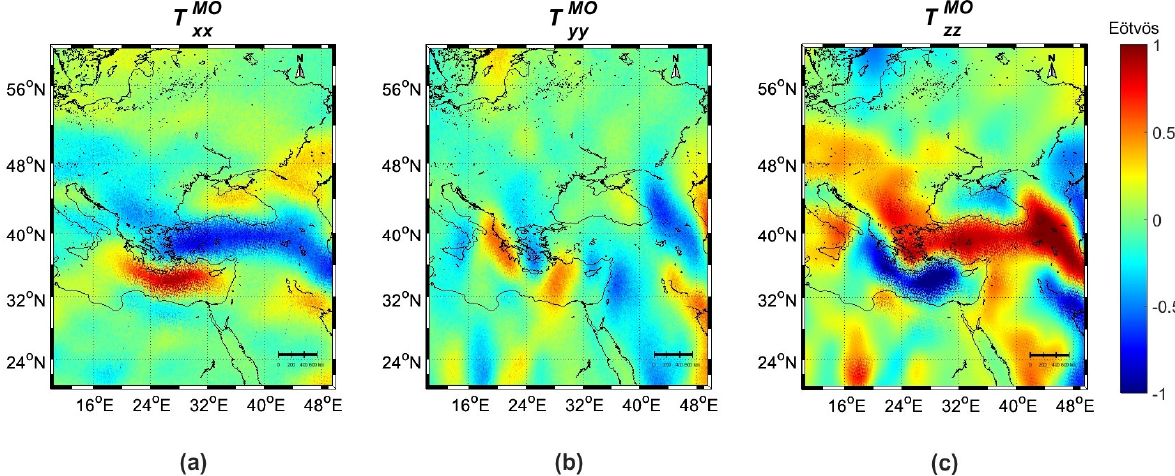
Figure 2. The projected to the MO ( a ) T MO xx , ( b ) T MO yy and ( c ) T MO zz gradients. Table 2. Statistics of the T ij before and after their projection to the MO. Units: (Eötvös). Orbit